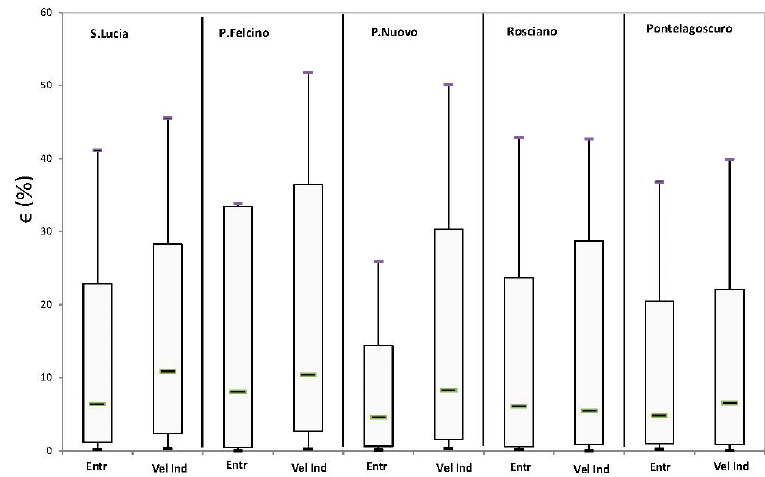
Figure 4. Box ‐ plot of absolute percentage errors ( (cid:2035) ) in estimating the depth ‐ averaged velocity using the entropy approach (Entr) and the velocity index (Vel Ind).